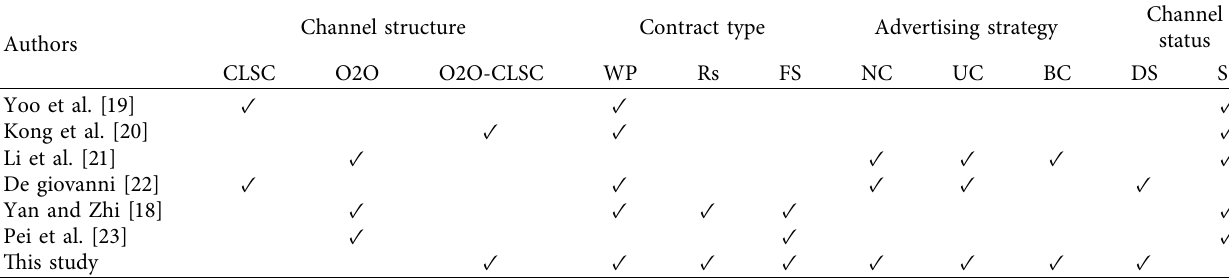
Table 1: Comparison of previous models and the current